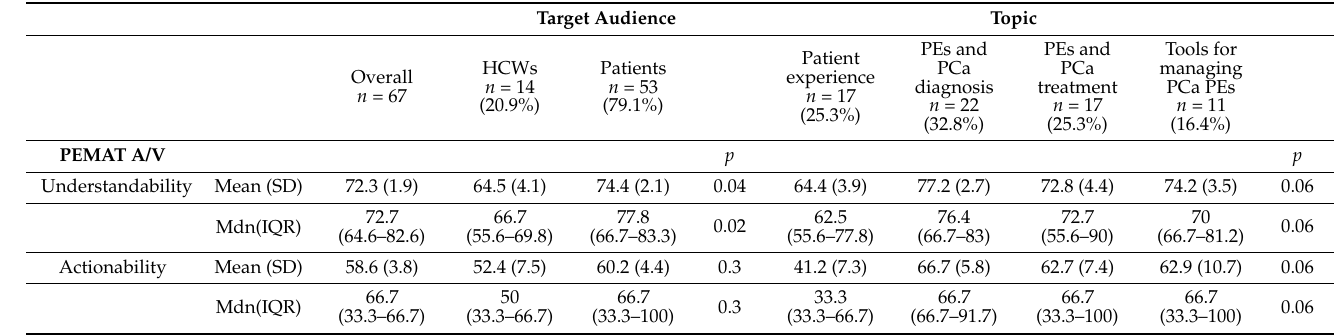
Table 2. PEMAT audio/visual (A/V) Understandability and Actionability of 67 YouTube videos on mental health of Pca patients stratified according to target audience (healthcare workers vs. patients) and topic (patient experience vs. psychological effects and PCa diagnosis vs. psychological effects and PCa treatment vs. tools for managing PCa psychological effects).